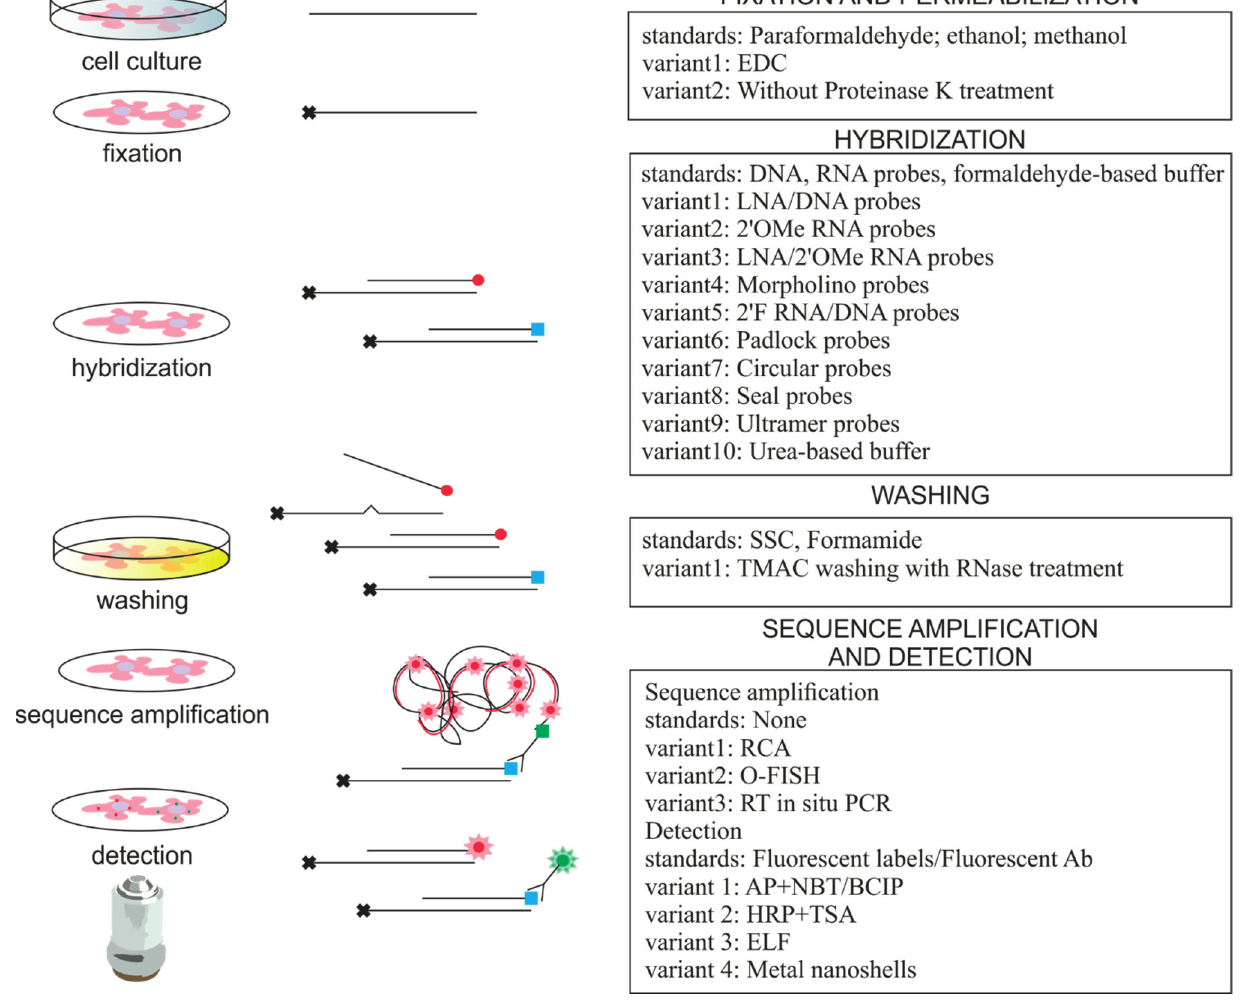
Figure 1. In situ hybridization protocols used for imaging of small RNAs. On the left are the steps of the ISH protocol on a cellular/tissue level, in the center are steps on a molecular level and on the right are modification variants of the ISH protocol used to detect small RNAs. Red and green dots represent fluorophores and squares represent non-fluorescent ligands. Black crosses indicate immobilization of